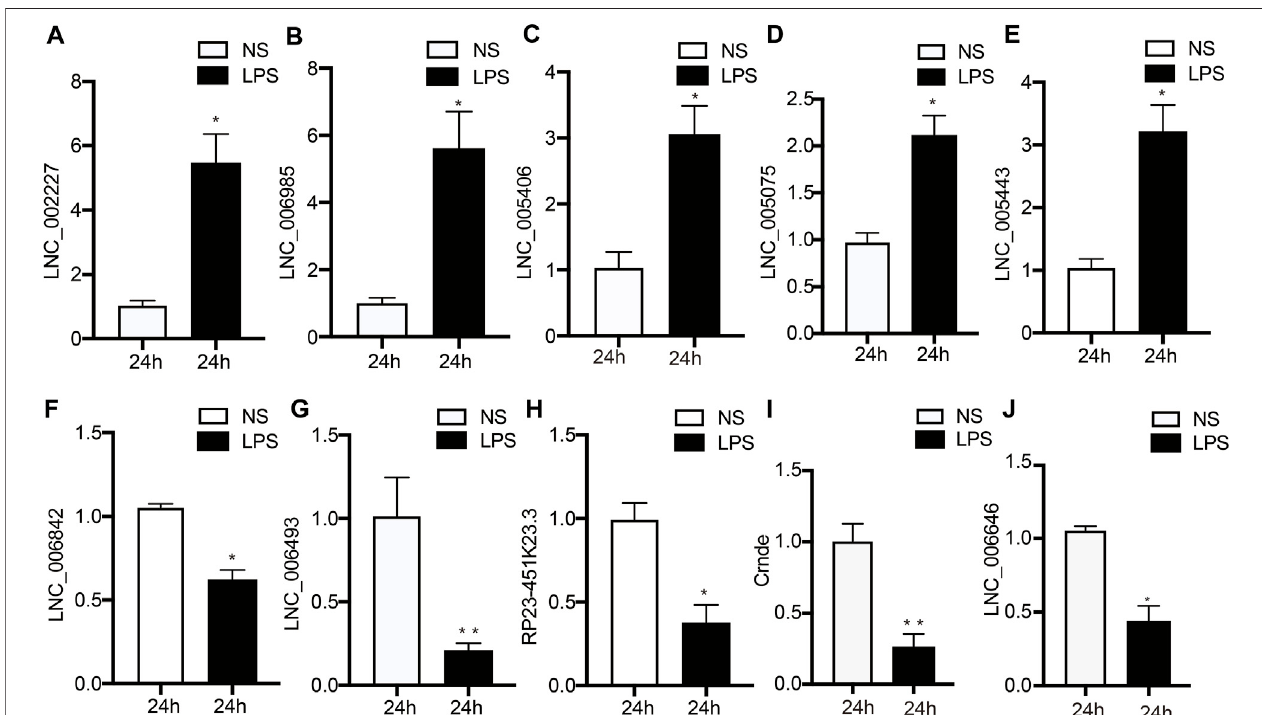
FIGURE 4 | Validation of DE lncRNA expression using RT-qPCR. (A – I) Changes in lncRNA expression were con fi rmed for DE lncRNAs in the LPS and NS groups by RT-PCR. Data are given as the mean ± SEM ( n (cid:1) 12); * p < 0.05; ** p < 0.01. LPS, lipopolysaccharide; NS, no lipopolysaccharide.